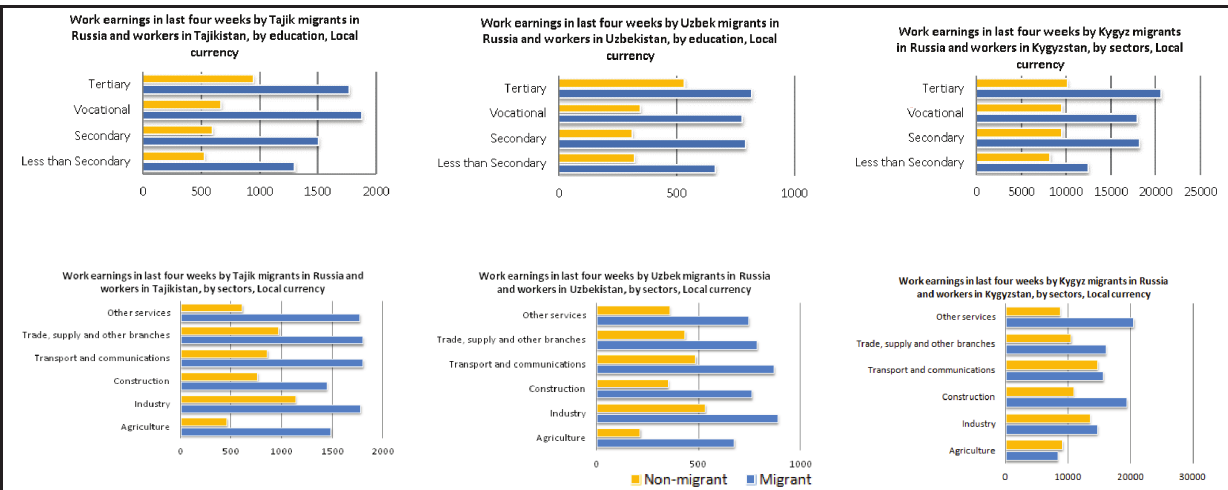
Mean wages between migrants in the Russian Federation and nonmigrants in their home countries (by education and